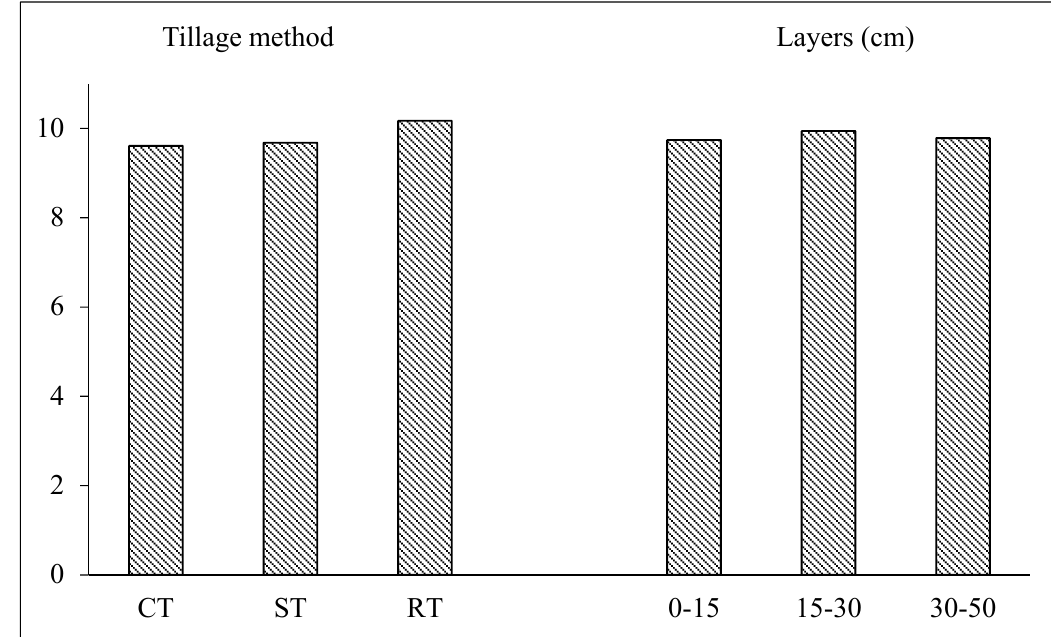
Figure 2. TOC/Nt ratio values. Figure 2. TOC / Nt ratio